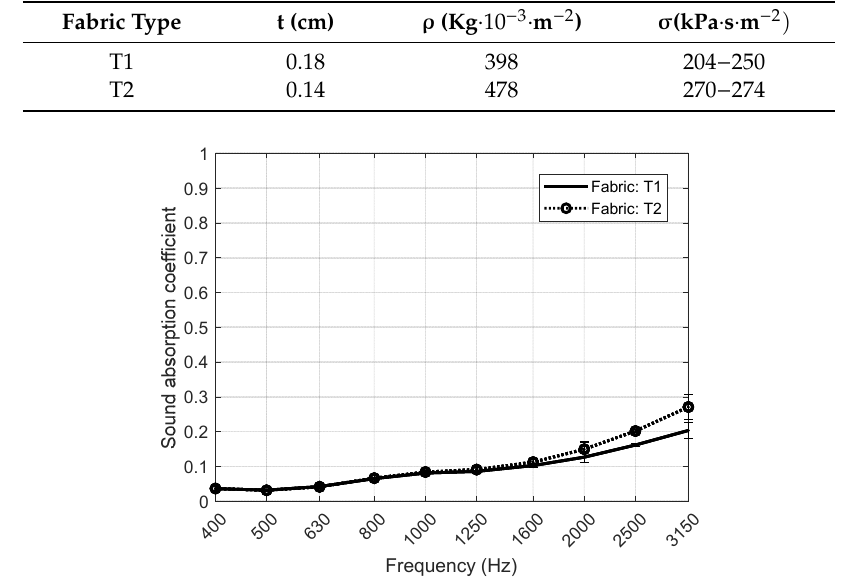
Figure 10. Sound absorption coefficient at normal incidence of the textile fabrics with their dispersion percentage.